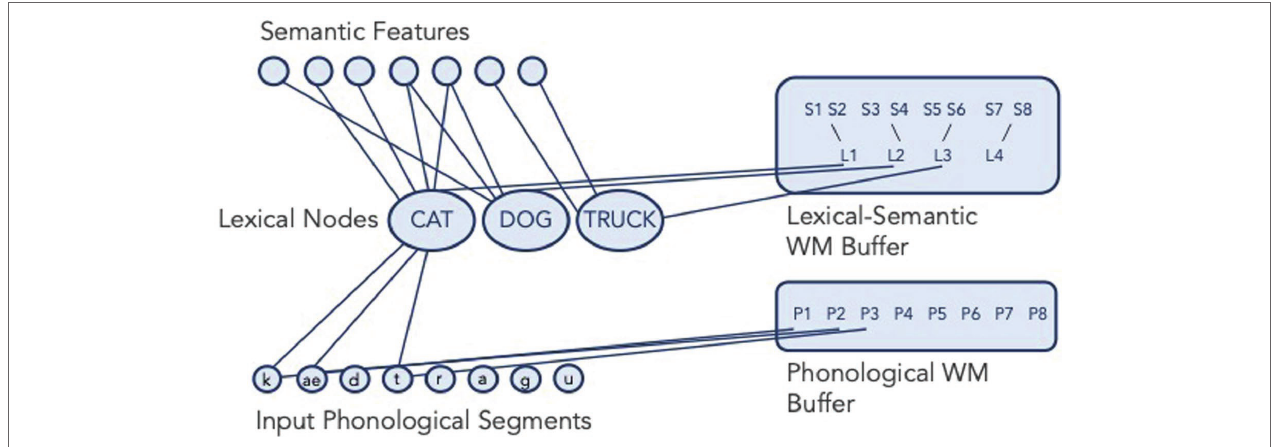
FIGURE 1 | The domain-specific model of WM (adapted from Martin et al.,